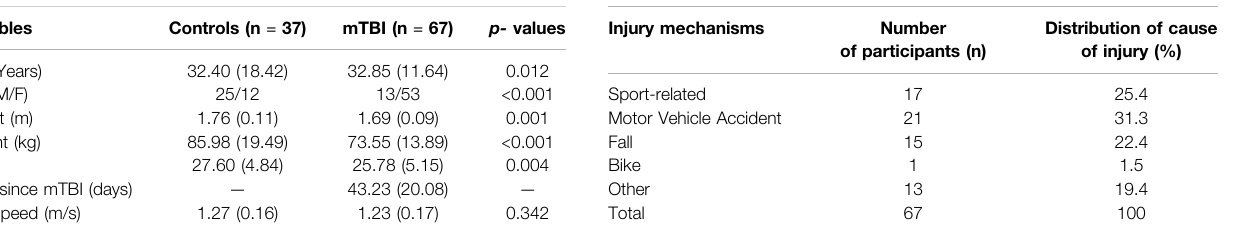
TABLE 1 | Demographic participant information. TABLE 2 | Injury Mechanism of participants of mTBI